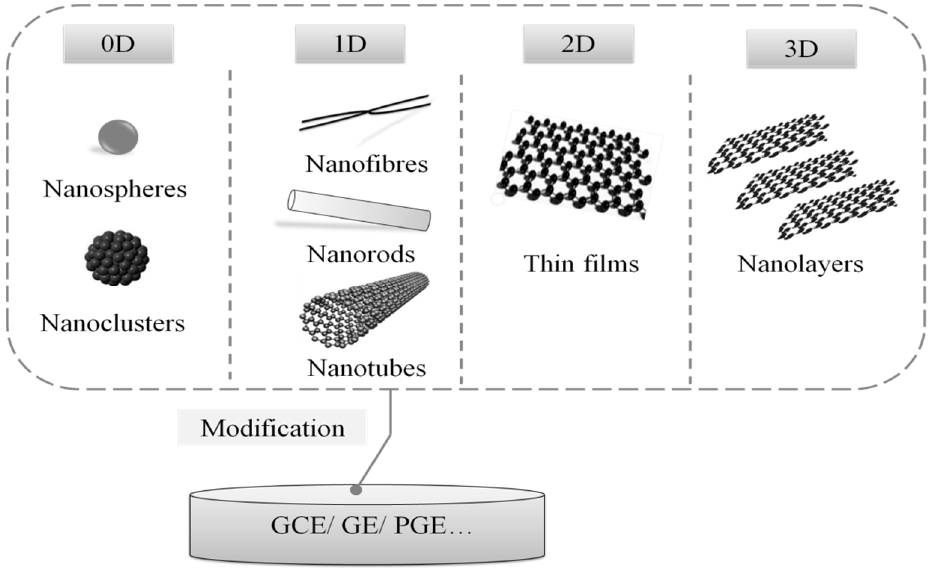
Figure 4. Nanomaterials commonly used in the modification of electrochemical DNA